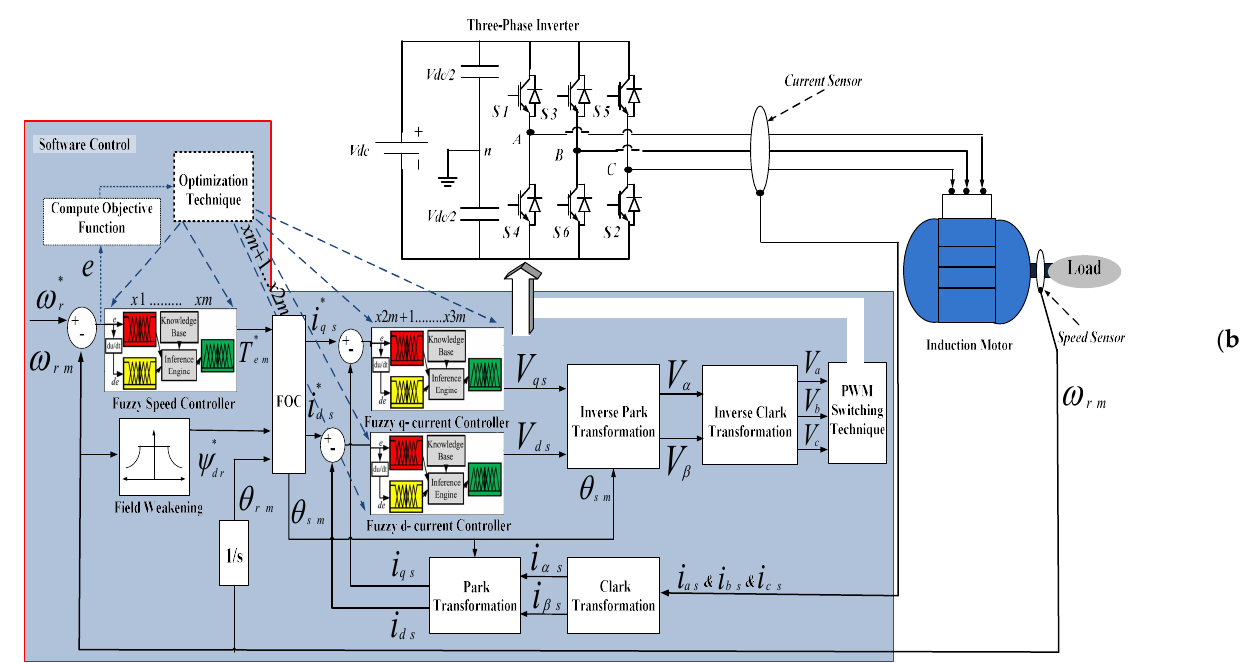
Figure 19. ( a ) Optimization technique for IFOC based on mixing ANN and FLC. ( b ). Optimization technique for IFOC based on FLC. technique for IFOC based on